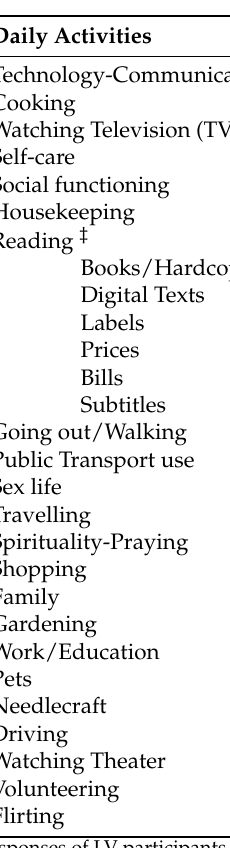
Table 1. Self-reported daily activities of LV patients (N = 110)